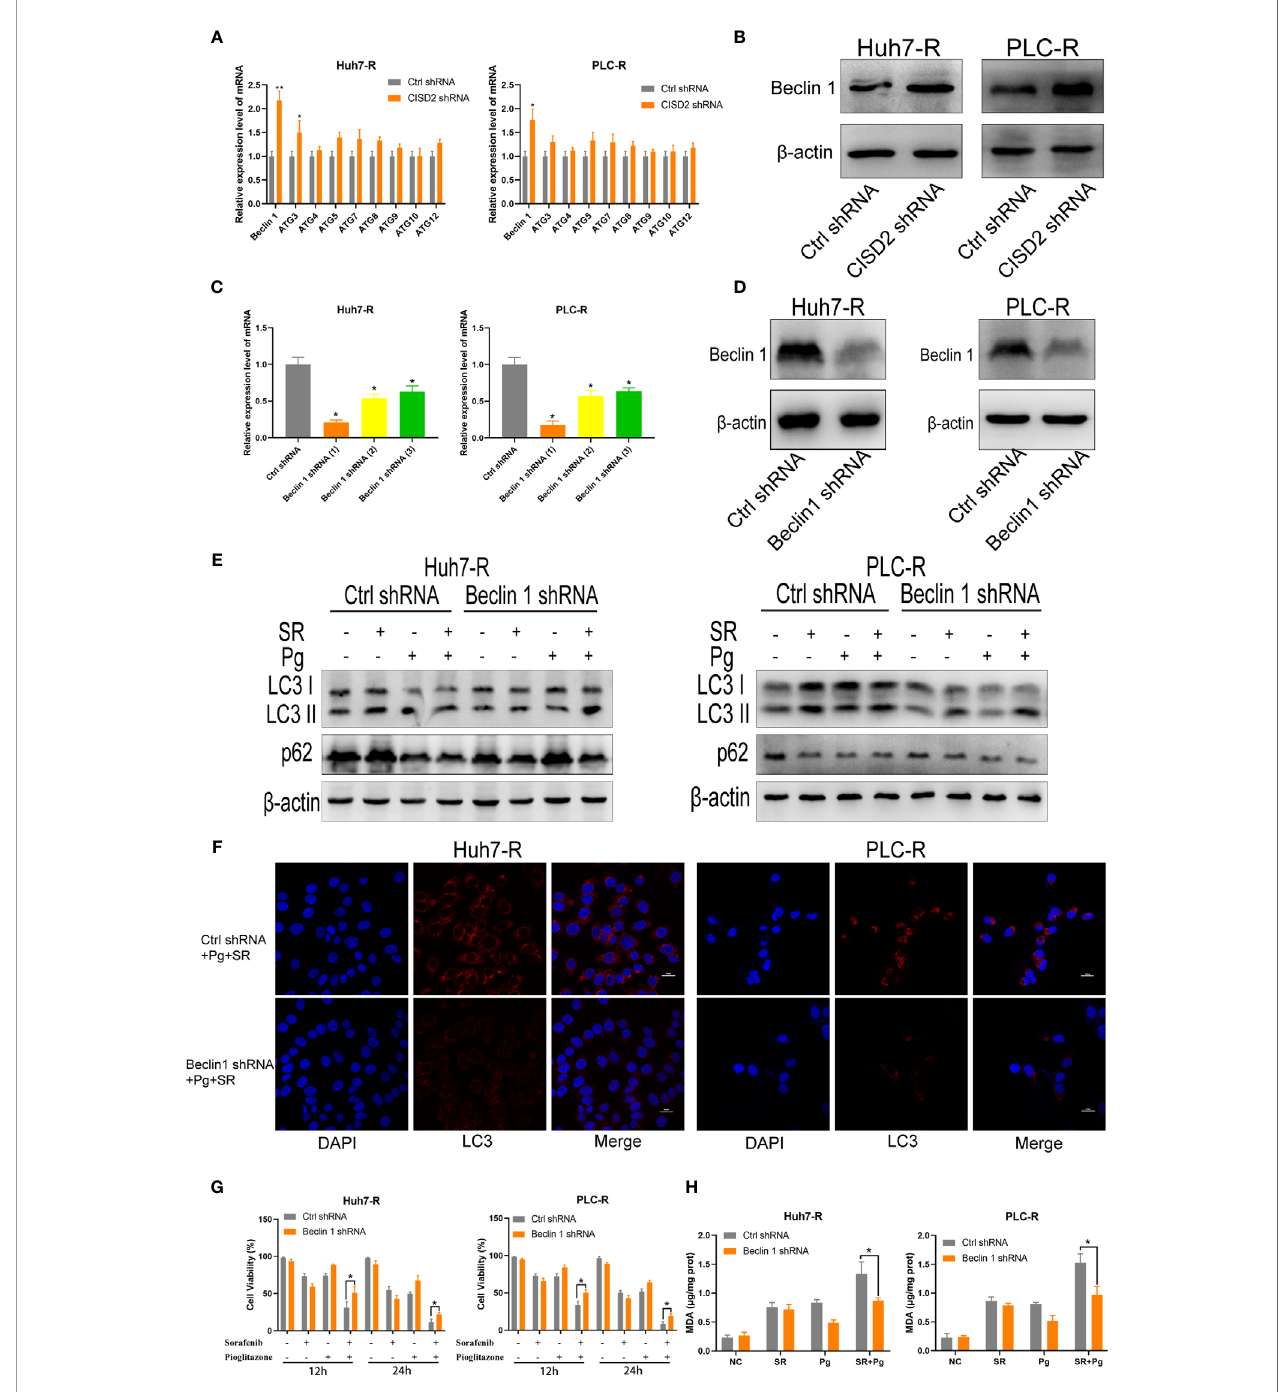
FIGURE 7 | Inhibition of CISD2 promotes ferroptosis regulated by Beclin1 in sorafenib-resistant cells. (A) qPCR was used to detect the autophagy-related gene expression under transfected CISD2 shRNA (n = 3, * P < 0.05, ** P < 0.01 versus Ctrl shRNA). (B) Western blot was used to detect the expression level of Beclin1 under transfected CISD2 shRNA. (C, D) qPCR and western blot were used to detect the Beclin1 expression under transfected Beclin1 shRNA (n = 3, * P < 0.05 versus Ctrl shRNA). (E) Western blot was used to detect the expression level of LC3, p62 under treatment with sorafenib (10 m mol), Pg (10 µmol), or transfected Beclin1 shRNA. (F) Immuno fl uorescence was used to detect the expression of LC3 under different treatment with sorafenib (10 m mol), Pg (10 µmol), or transfected Beclin1 shRNA. (G) CCK-8 was used to detect the cell viability under treatment with sorafenib (10 m mol), Pg (10 µmol), or transfected Beclin1 shRNA (n = 3, * P < 0.05 versus Ctrl shRNA). (H) MDA kit was used to detect the expression of MDA under treatment with sorafenib (10 µmol), Pg (10 µmol), or transfected Beclin1 shRNA (n = 3, * P < 0.05 versus Ctrl